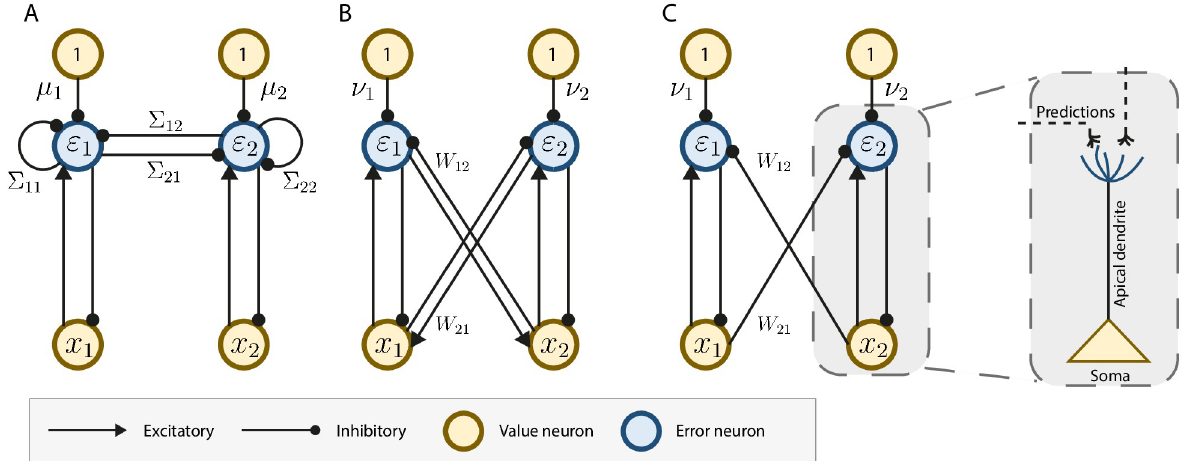
and ε denotes the a -th value/error neuron in the networks. a a